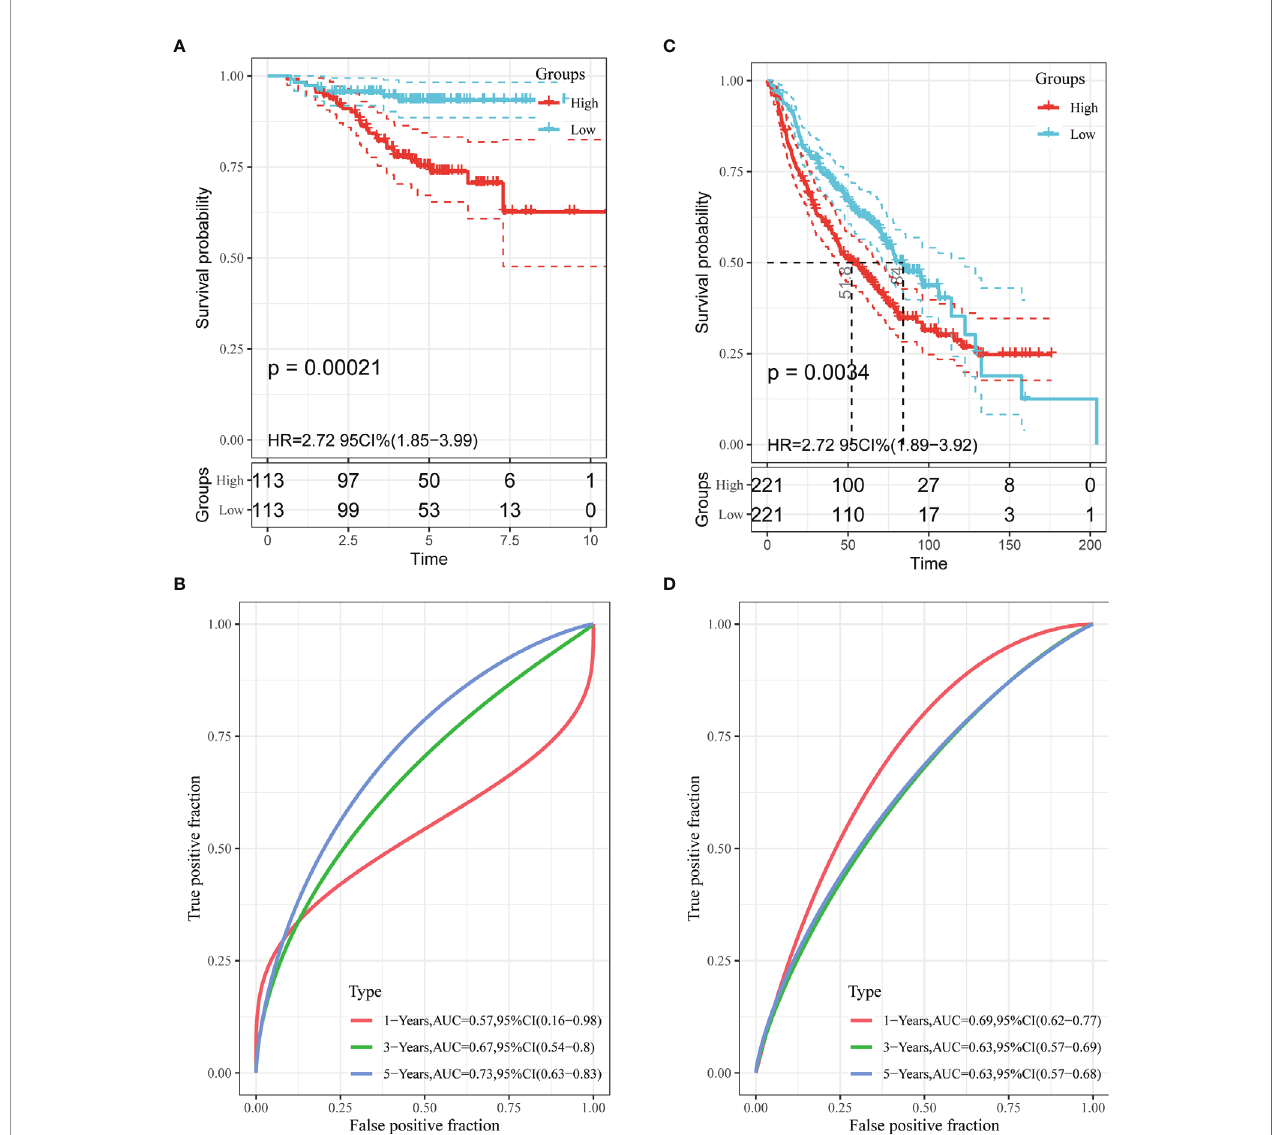
FIGURE 5 | Validation of the performance of the risk model in the GEO cohorts. Kaplan – Meier curves of the OS in the GSE31210 cohort (A) and GSE68465 cohort (C) . ROC curves and area under the curve (AUC) for 1-, 3-, and 5-year survival in the GSE31210 cohort (B) and GSE68465 cohort (D)